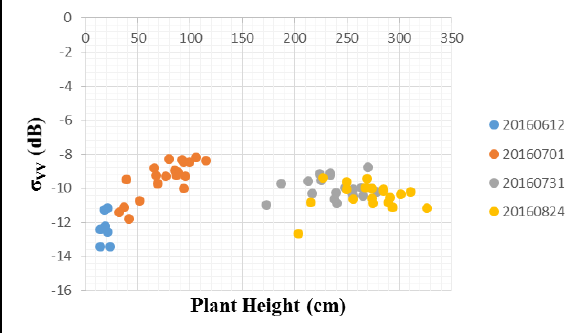
Figure 4. Correlation between σ VV and Plant Height.